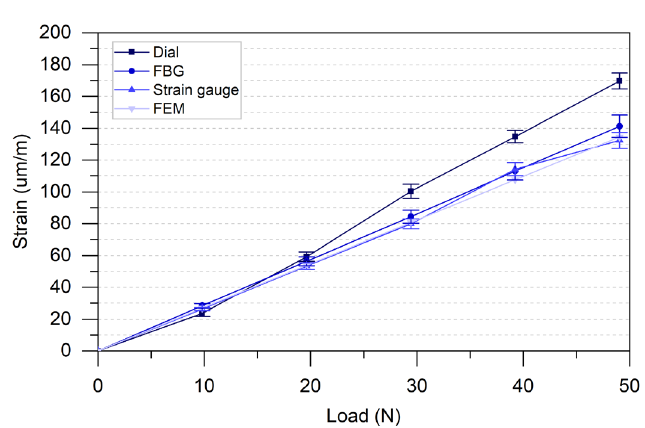
Figure 9. Strain measured by